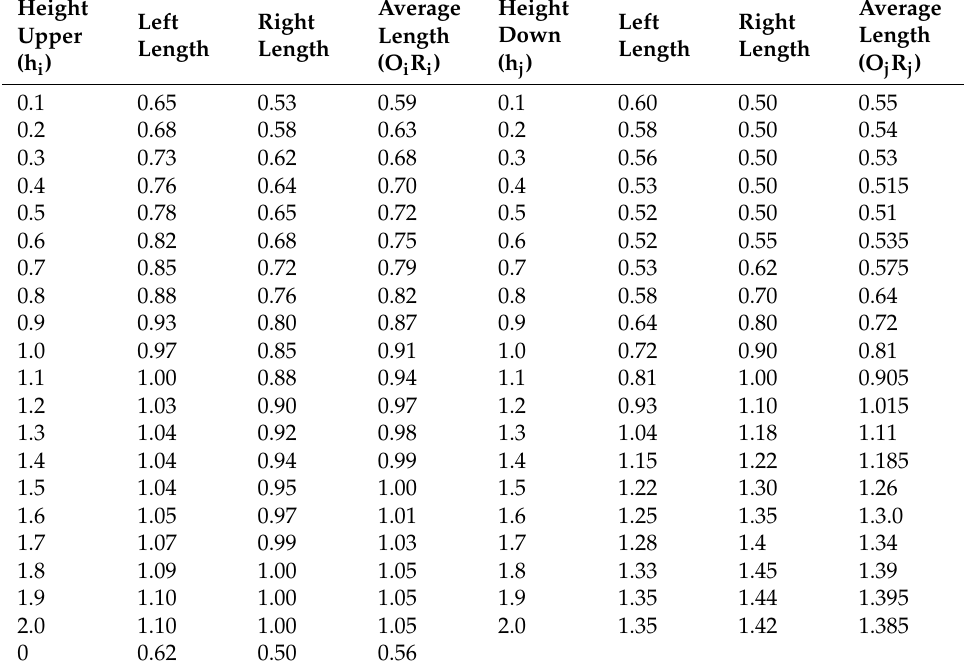
Table A1. Cross-sectional profile of case S2 weld seam. (Unit: mm).